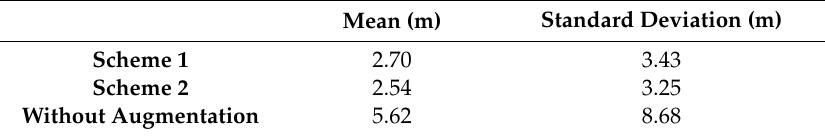
Table 4. Average positioning error for the augmentation schemes .